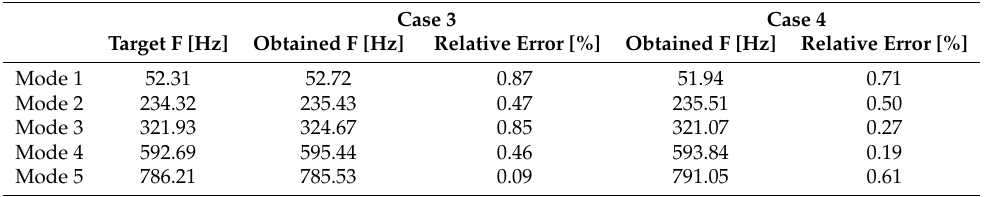
Table 4. Comparison between the target frequencies and obtained ones for Cases 3 and 4. F denotes